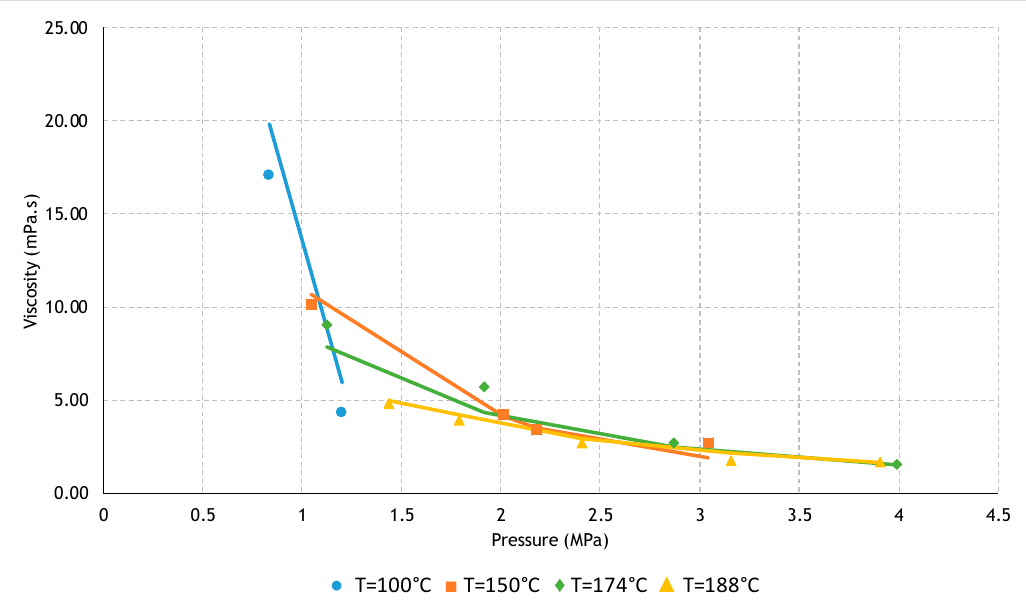
Figure 6. Vapour–liquid equilibrium diagrams for the solvents that were co-injected with the steam in the simulations.